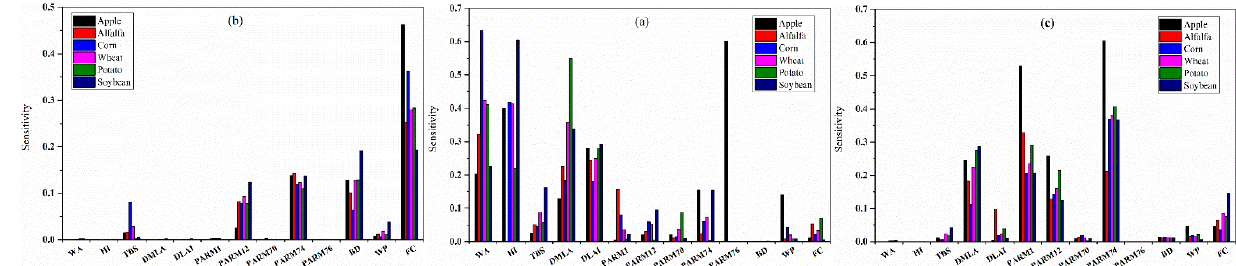
Figure 3. Sensitivity of yield, evapotranspiration and soil moisture for apple, alfalfa, corn, soybean and potato, ( a ) Yield, ( b ) evapotranspiration, ( c ) soil moisture.